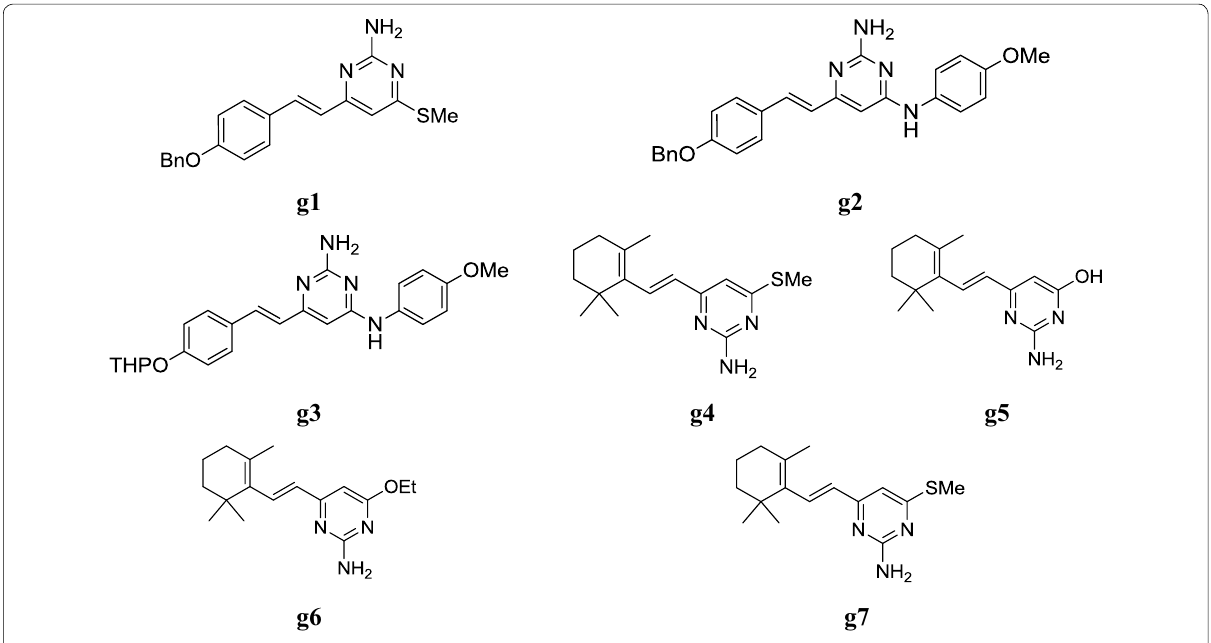
Fig. 13 Chemical structures of the most active antileishmanial pyrimidine derivatives ( g1 – g7 )